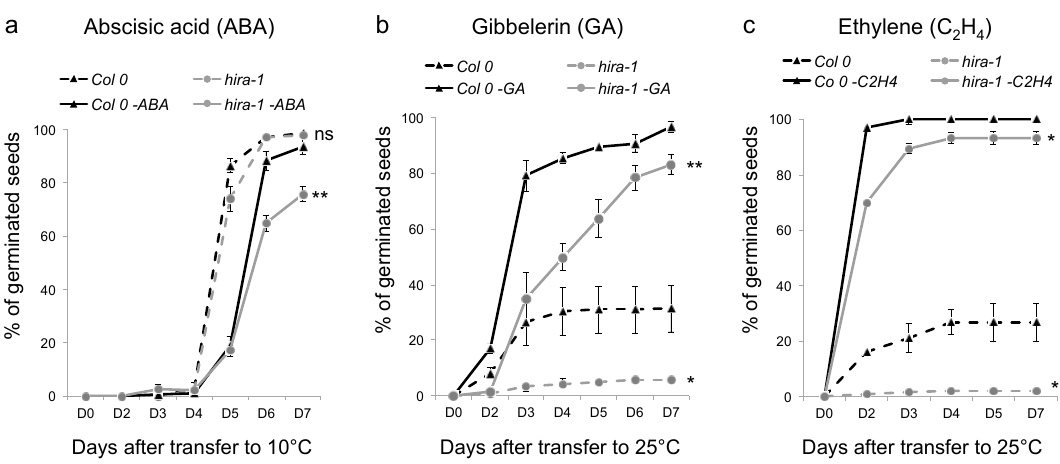
Figure 4. Enhanced seed dormancy of hira-1 mutants is not alleviated upon treatment with ABA, GA or ethylene. Germination of Col-0 (black, square) and hira-1 mutant (dark grey, circle) seeds in presence (filled line) or absence (dashed line) of ABA (1 µM) ( a ) at 10 °C in darkness or of GA (1 mM) ( b ) and ethylene (50 ppm) ( c ) at 25 °C in darkness. Means of biological triplicates with SEM are shown. Statistically significant differences relative to WT at D7 were determined using a two-sided Student’s t -test (* p < 0.05; ** p < 0.01; ns = not